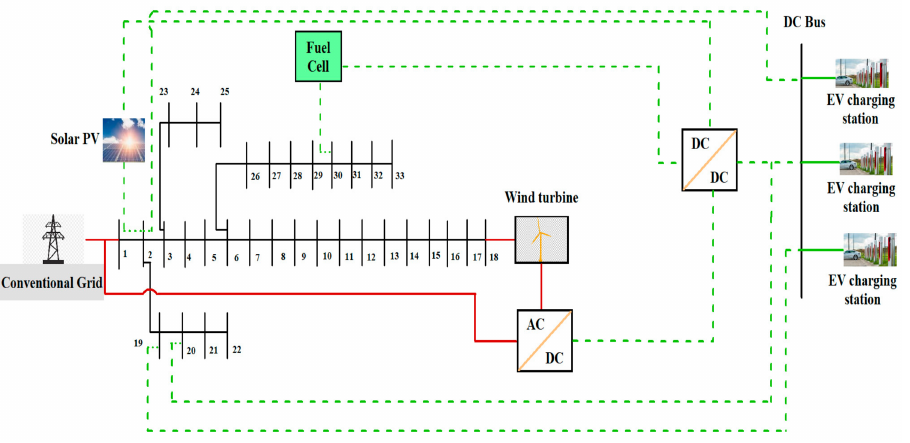
Figure 4. Framework of modified IEEE 33-bus test